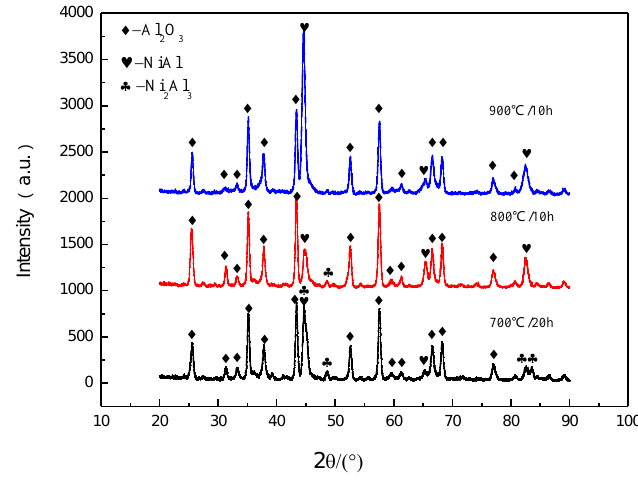
Figure 5. XRD patterns of the Al/Ni coatings after 973 K/20 h, 1073 K/10 h, and 1173 K/10 h in-situ reaction.